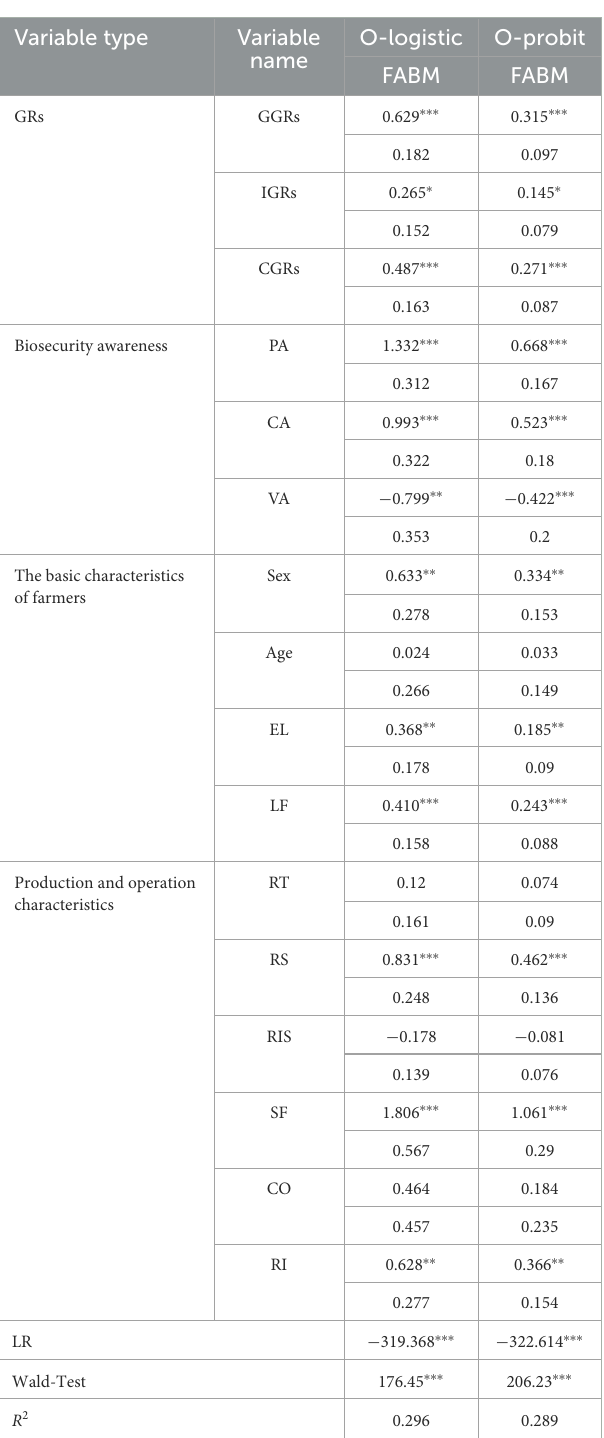
TABLE 3 Benchmark regression